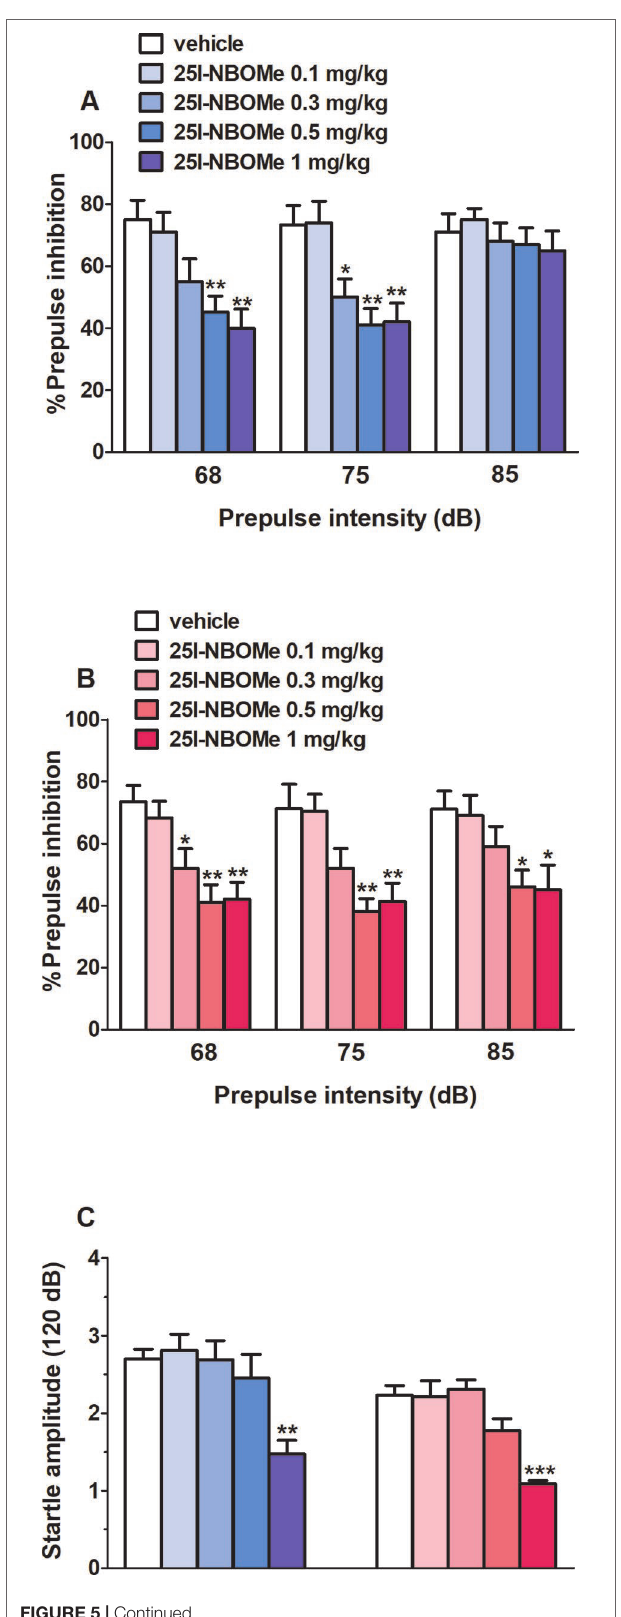
FIgURe 5 | Effect of the systemic administration of 25I-NBOMe (0.1–1 mg/ kg, i.p.) on prepulse inhibition (PPI) in male (A) and female (B) rats and on startle amplitude for both sexes (c) . Effects on PPI are shown for the three prepulse intensities (68, 75, and 85 dB) 30 min after treatment (A and B) . Data are expressed (see Material and Methods ) as percentage decrease in the amplitude of the startle reactivity caused by presentation of the prepulse (% PPI) (A and B) and absolute values (in dB) (c) . Values represent the mean ± SEM of seven animals for each treatment. Statistical analysis was performed by one-way ANOVA followed by Bonferroni’s test for multiple comparisons. * p < 0.05, ** p < 0.01, *** p < 0.001 versus